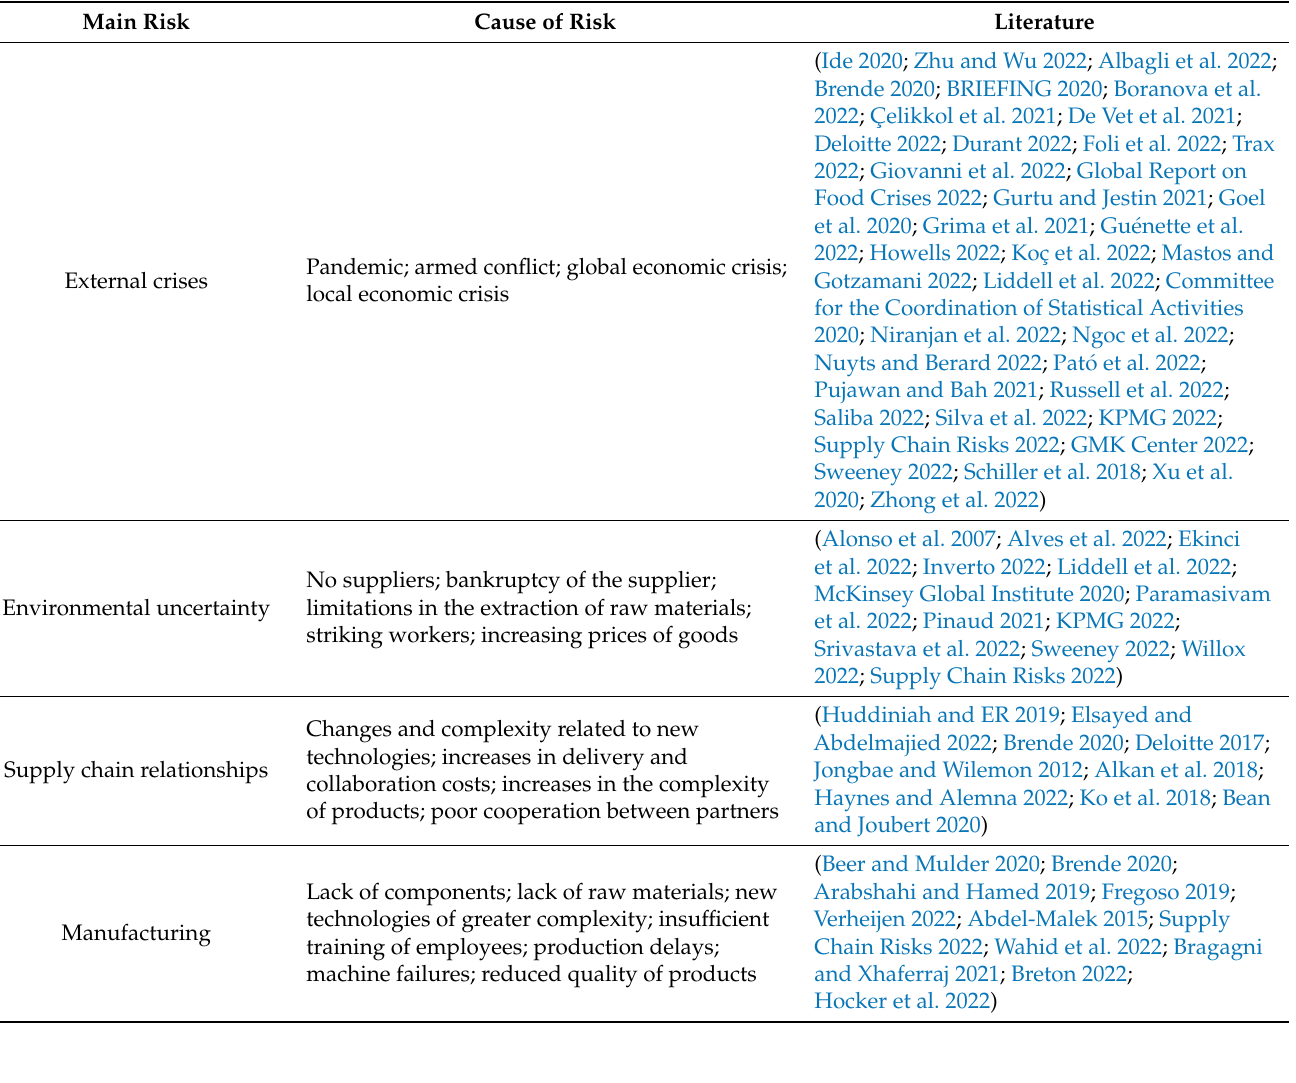
Table 4. Literature sources of risk causes in supply